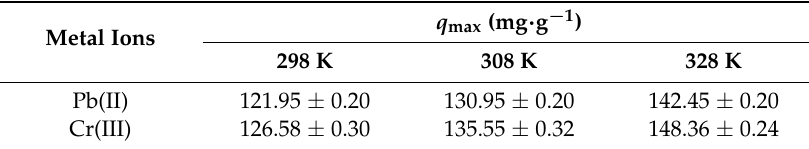
Table 4. Langmuir isotherm parameters of Pb(II) and Cr(III) ( C o = 2.0 to 25 mg · L − 1 ) adsorption onto rGONF at pH 5.0 for Pb(II) and pH 4.0 for Cr(III), with 30 min equilibrium time for the range of reaction temperatures, 298–328 K ( n = 3, mean ± SD).